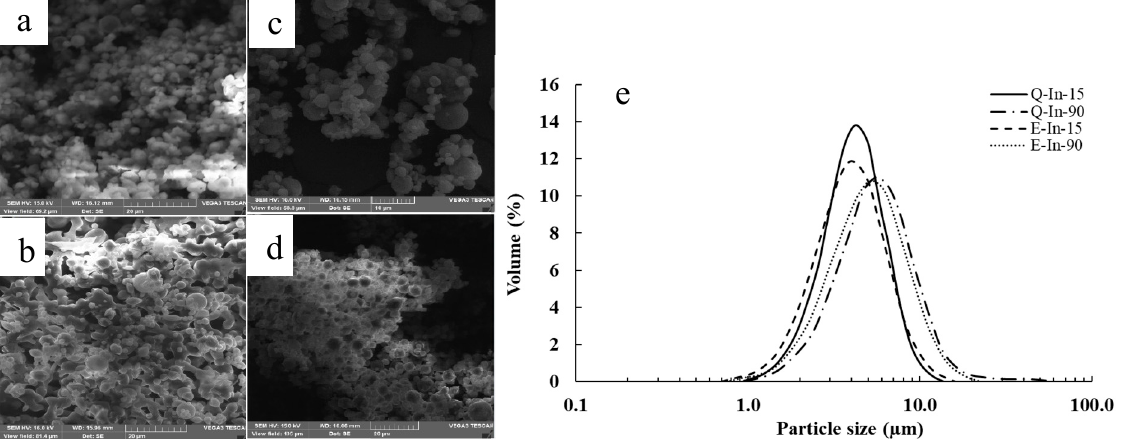
Figure 3. SEM photographs ( a–d ) and particle size distribution ( e ) for flavonoid-inulin microparticles. a: E-In-15; b: E-In-90; c: Q-In-15; d: Q-In-90.